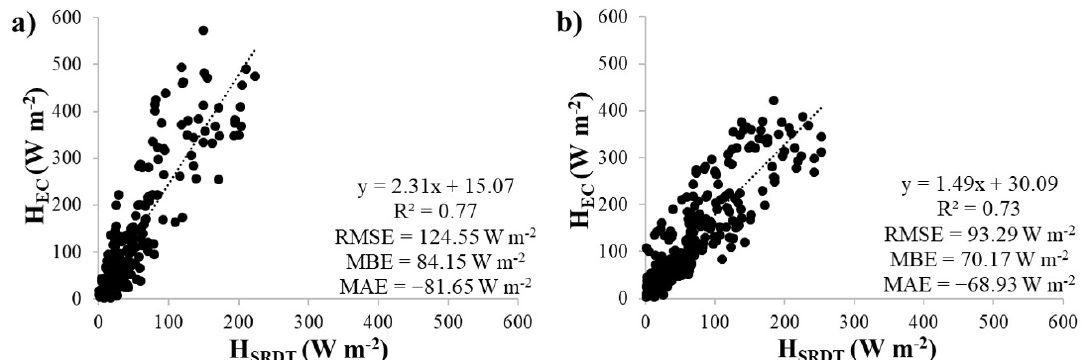
Figure 6 . Linear regression analysis between H SRDT and H EC for the upper thermocouple using the 0.4 s time lag at the ( a ) control and ( b ) cut plots.